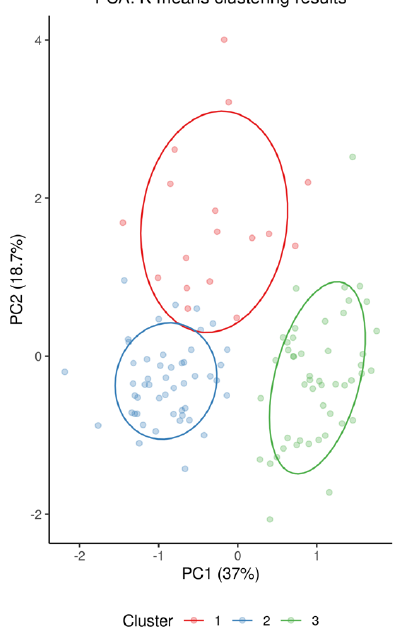
Figure 10. Results from K-means clustering, using only the 34 biomarkers that statistically significantly differentiate symptomatic COVID-19 patients from all of the other phenotype groups, visualized via principal component analysis. Table 2. Allocation to predicted clusters based on K-means clustering.